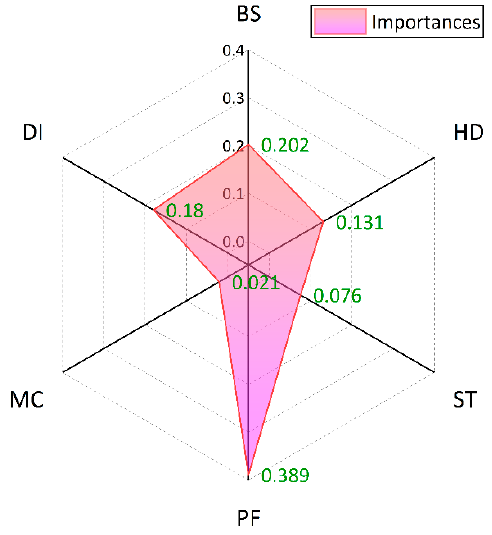
21 of 26 Figure 13. Measured and predicted PPV of the RF-WOA model on the testing set. 4.3. Sensitivity Analysis of Predictor Variables Owing to the possible hazards of the PPV that are caused by blasting operations, it is indispensable to clarify the major factor affecting the PPV. Therefore, in this section, fur- ther analysis is conducted to identify the significant correlation of predictor variables that are used to predict the PPV. As previously stated, six variables, i.e., BS, HD, ST, PF, MC, and DI, were used to develop the RF models in this study. Based on the attribute of the RF model, a significant correlation of each input variable can be obtained. The (normal- ized) total decrease in the criterion brought by a feature is used to calculate the input var- iable’s relevance with the target variable, which is also known as the Gini importance